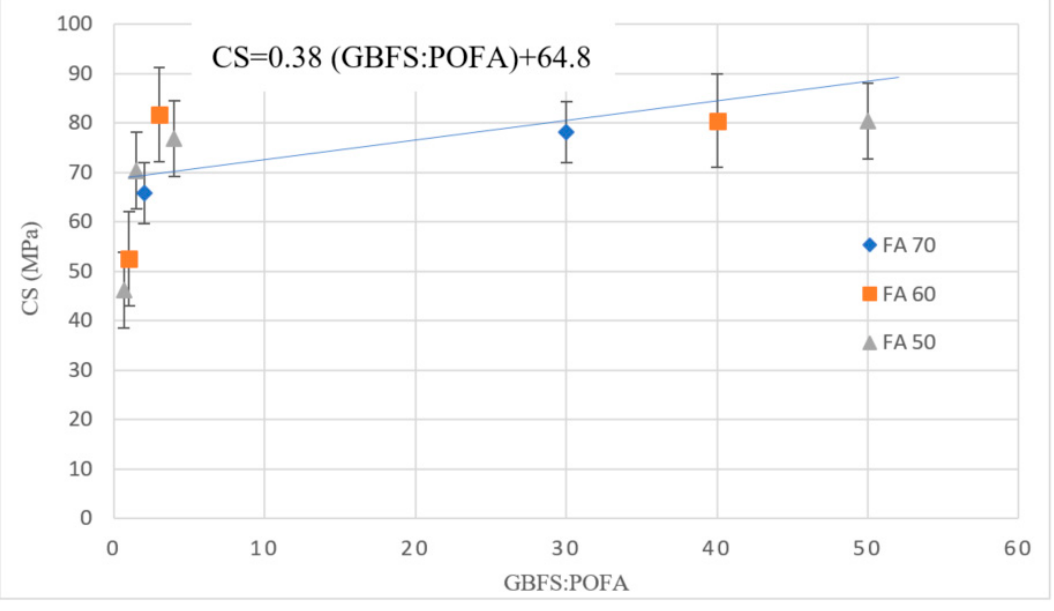
Figure 4. CS of AAM designs with a high volume of POFA.